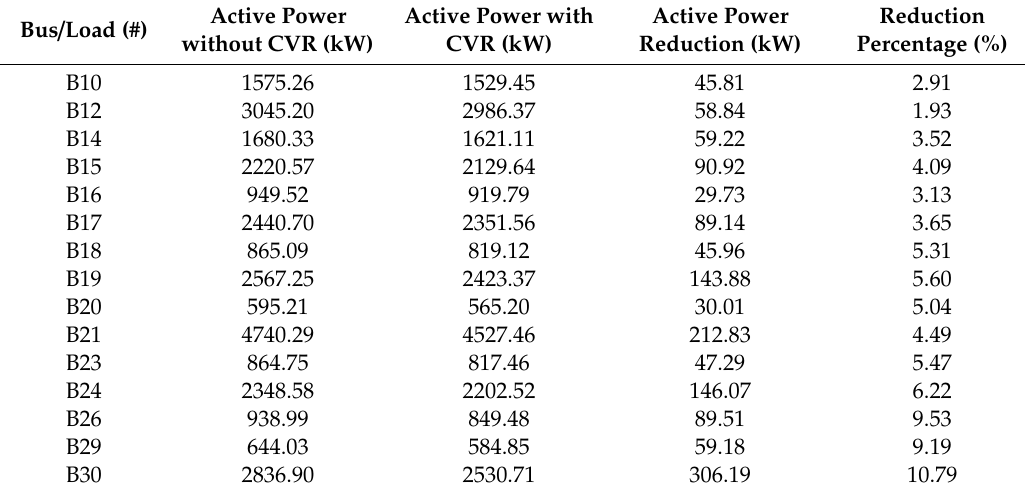
Table 5. Case V: Active power with / without CVR in the presence of DG.